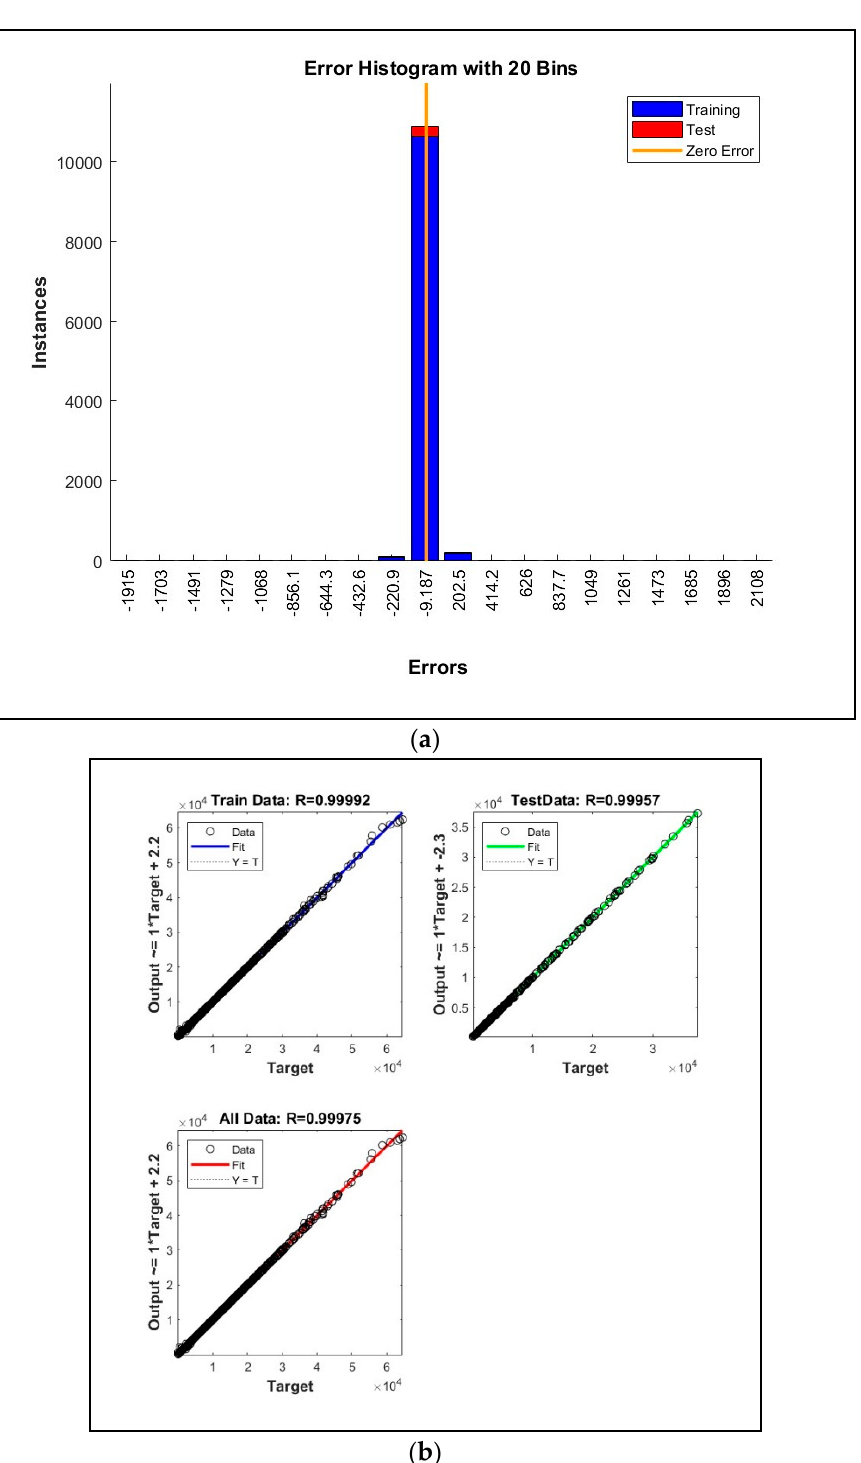
Figure 4. The BestDAG’s performance charts. ( a ) The histogram of error values. ( b ) The regression plots between the targets and outputs.